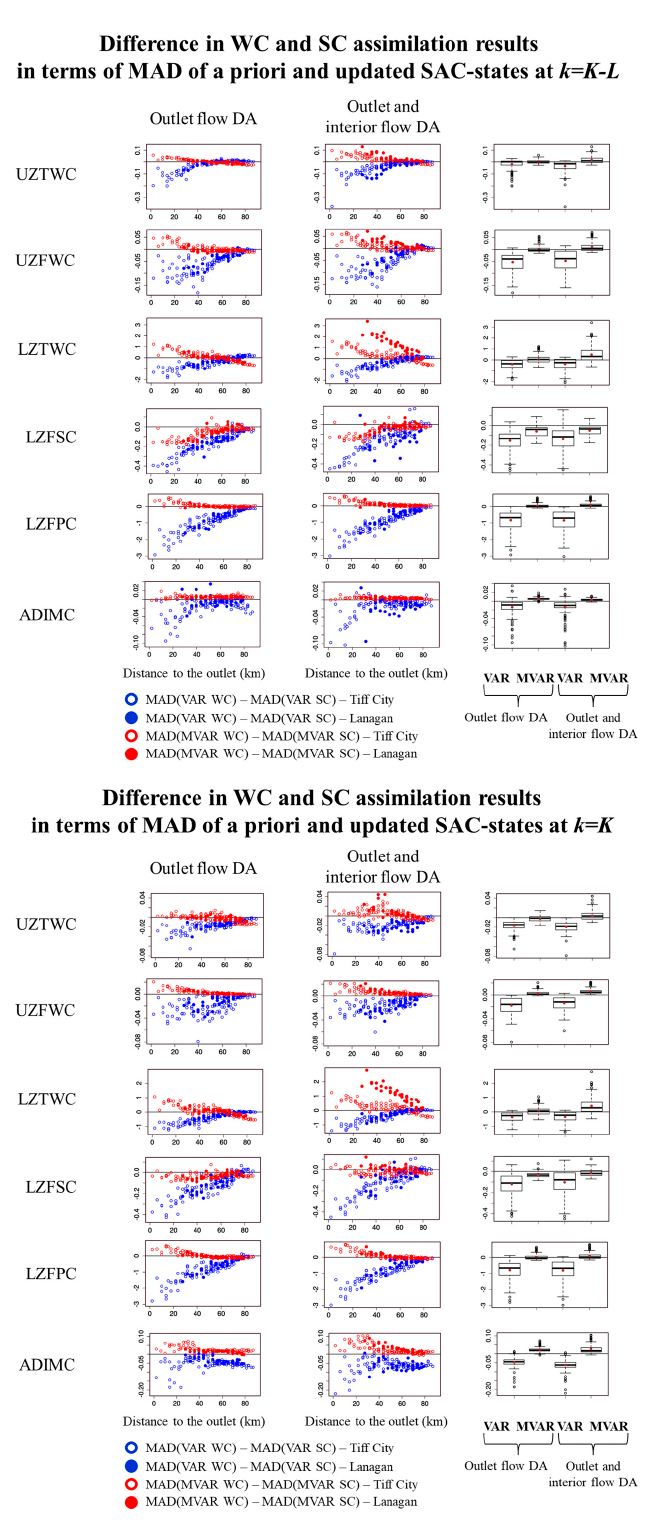
Figure 7. Di ff erences in weakly- (WC) and strongly-constrained (SC) assimilation results in terms of MAD of background and updated model states at the beginning ( k = K − L ; top panel) or end ( k = K ; bottom panel) of the assimilation window. Box plots were created using the entire basin results, that is, Ti ff